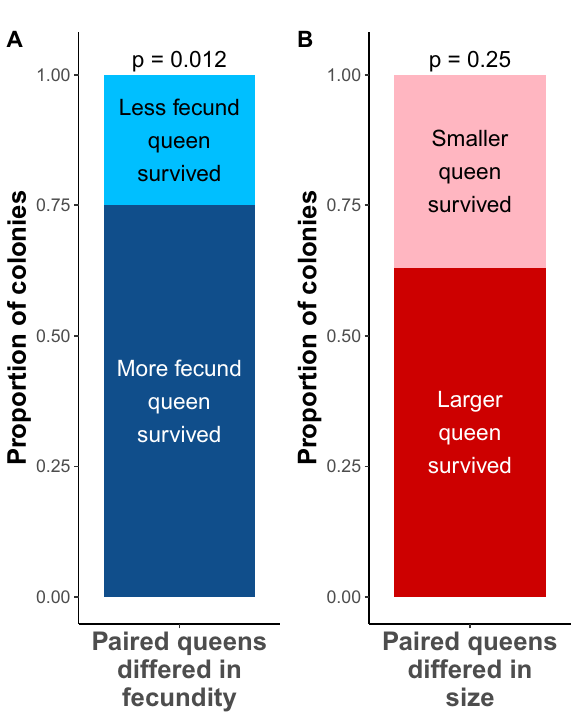
Figure 4. Likelihood of surviving the pleometrotic association depending on queen ( A ) fecundity (n = 28) and ( B ) size (n = 27). P values come from binomial